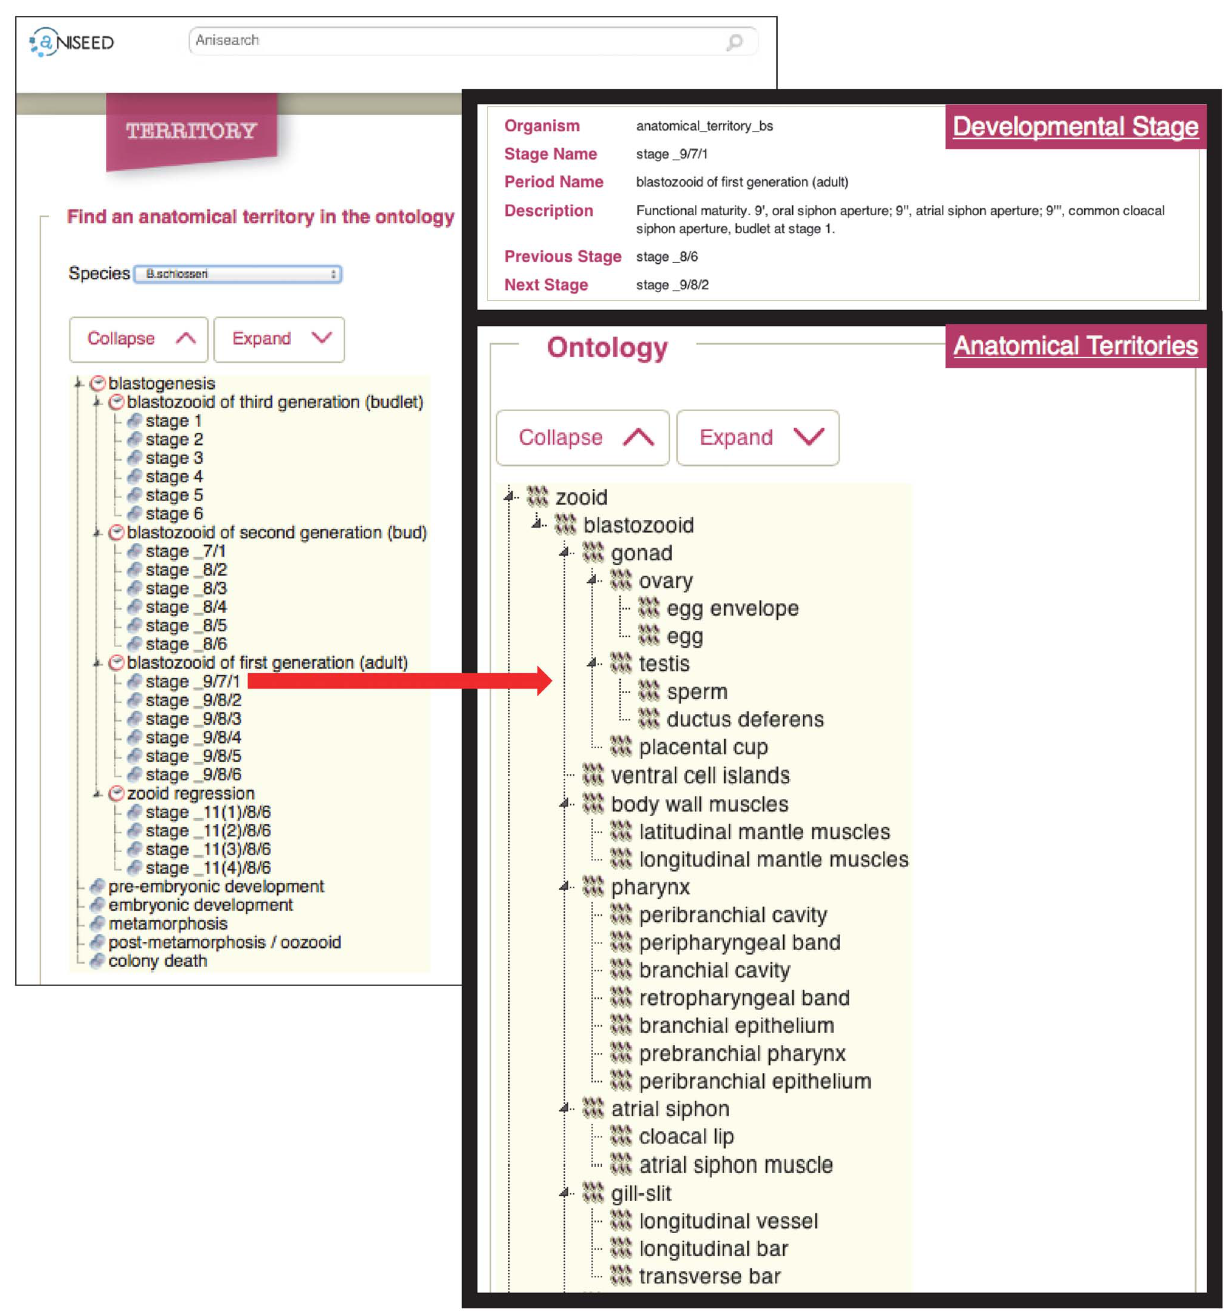
Figure 4. Schemes illustrating BODA in NISEED. BODA can be easily browsed using the NISEED platform (www.aniseed.cnrs.fr), which represents the reference portal in the tunicate community. It is possible to access the ontologies through the menu ‘‘anatomy’’, select the stage of interest and access to the corresponding definitions and relations. doi:10.1371/journal.pone.0096434.g004 (BSA:0000056) open. The colonial circulatory system consists of a network of vessels of epidermal origin, branching from the zooids and buds, crossing the tunic, and connecting to a marginal vessel, which runs along the periphery of the colony [76]. The vessels terminate toward the tunic surface in oval-shaped blind ends: the blood ampullae (BSA:0000045).